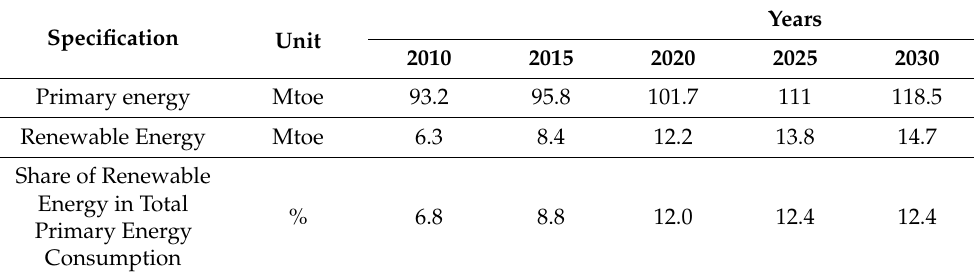
Table 2. Past and forecast of the demand for primary and renewable